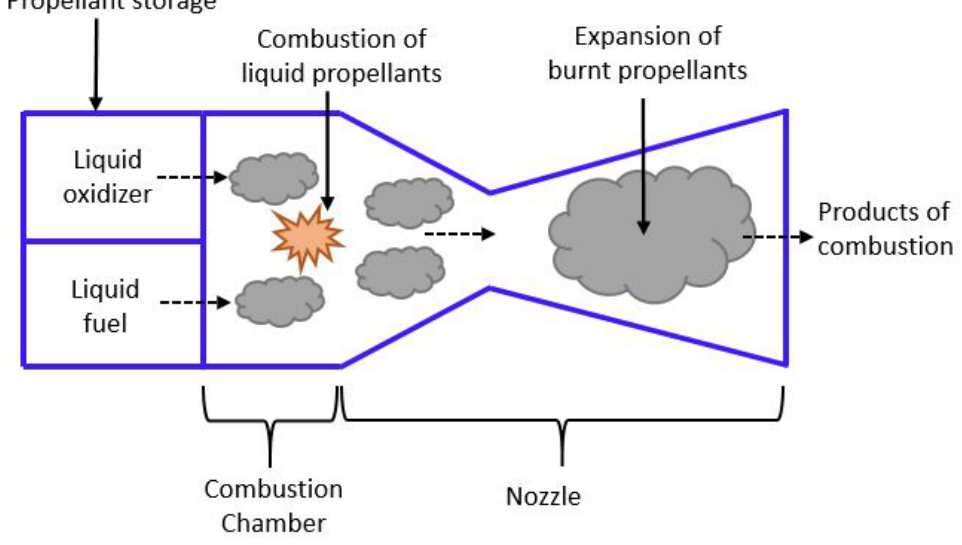
Figure 2. Schematic of a Bi-propellant Liquid Propulsion